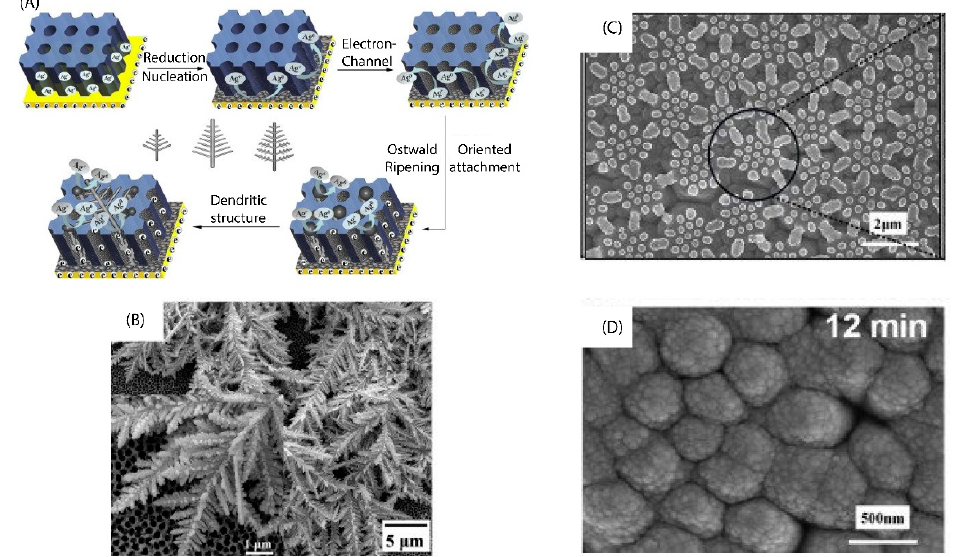
Figure 7. ( A ) Diagram depicting the development of silver dendritic on the AAO substrates, and ( B ) FESEM image of silver dendritic on AAO substrates. Adapted with permission from [69], Copyright 2016, Elsevier. (C) FESEM image of PDMS surface after copying from the diatom, and ( D ) FESEM image of PDMS surface reproduced from diatoms after creating a sputtering Au coating. Adapted with permission from [70], Copyright 2020, Elsevier.